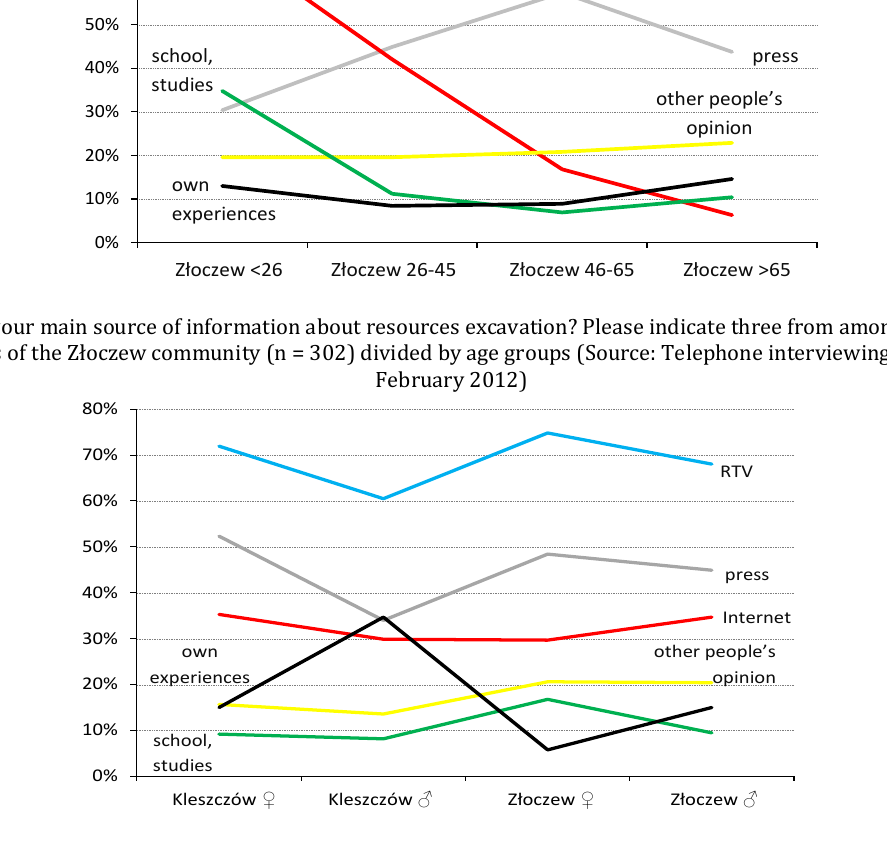
Fig. 5. What is your main source of information about resources excavation? Please indicate three from among the given ones. The inhabitants of the Kleszczów community (n = 300) and the Złoczew community (n = 302) separately, divided by gender